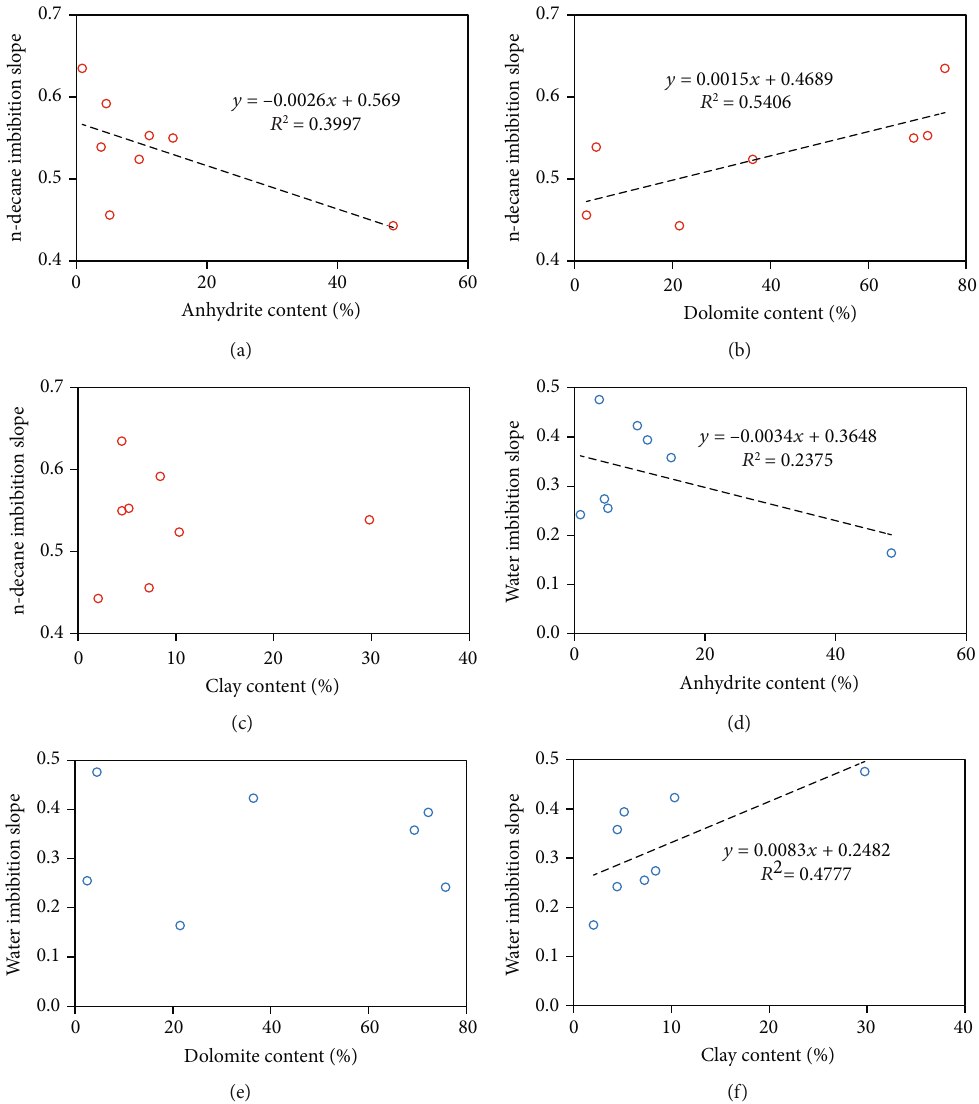
Figure 11: Crossplots of spontaneous imbibition parameters and mineral compositions of the Palaeogene Xiaganchaigou Formation samples from Qaidam